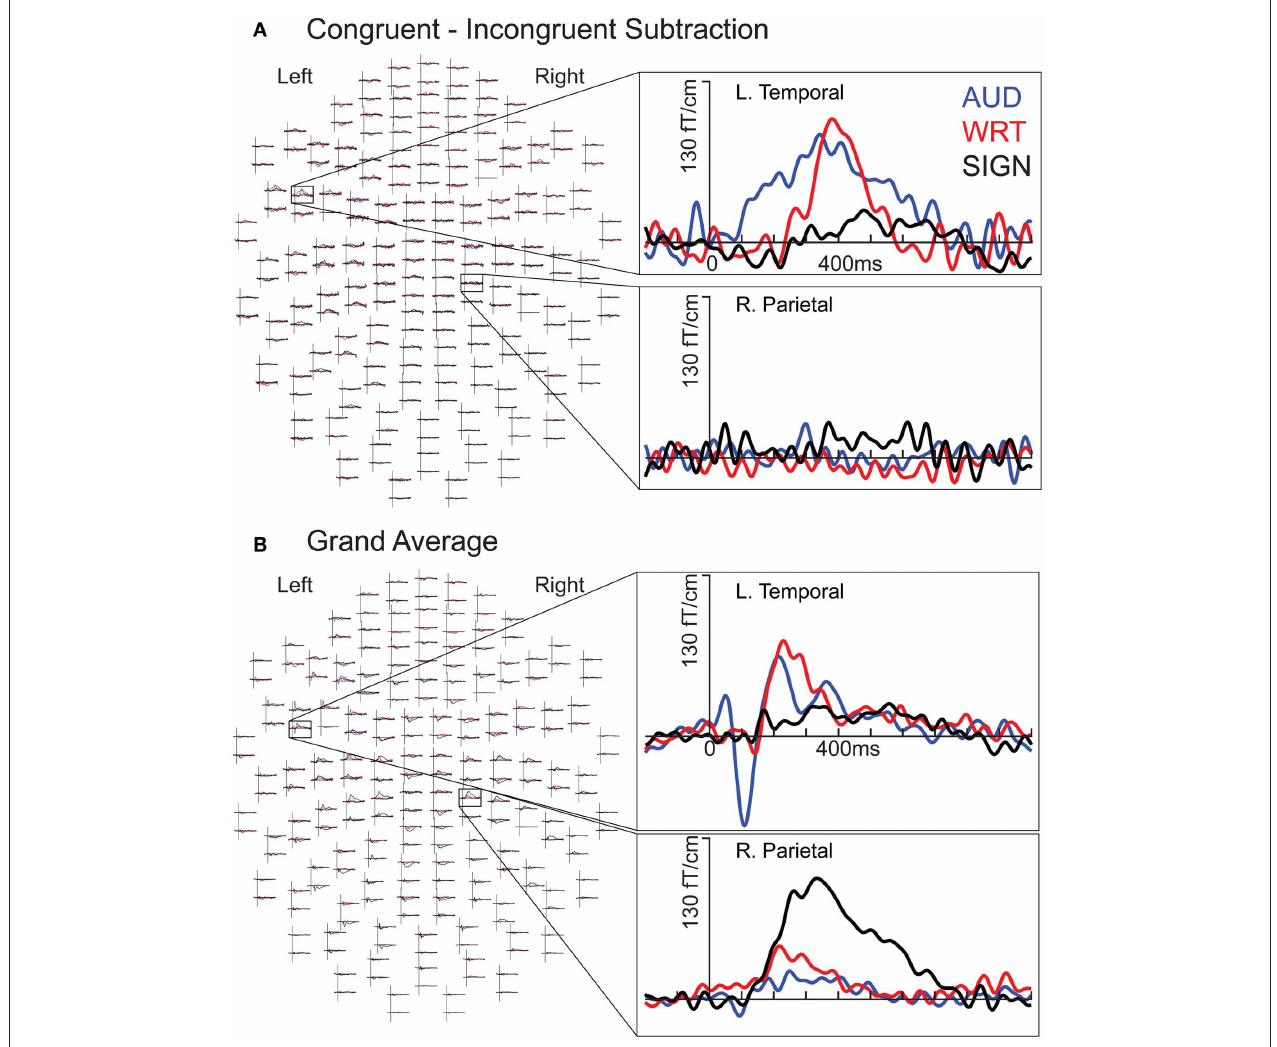
FIGURE 2 | Individual subject waveforms showing sensor-level language/modality effects. (A) Congruent-Incongruentwaveforms for each modality for a left temporal channel (top) show greater responses for auditory (“AUD”;blue) and written (“WRT”;red) than for signed (“SIGN”;black) words. In a right parietal channel (bottom), there are no strong responses in any